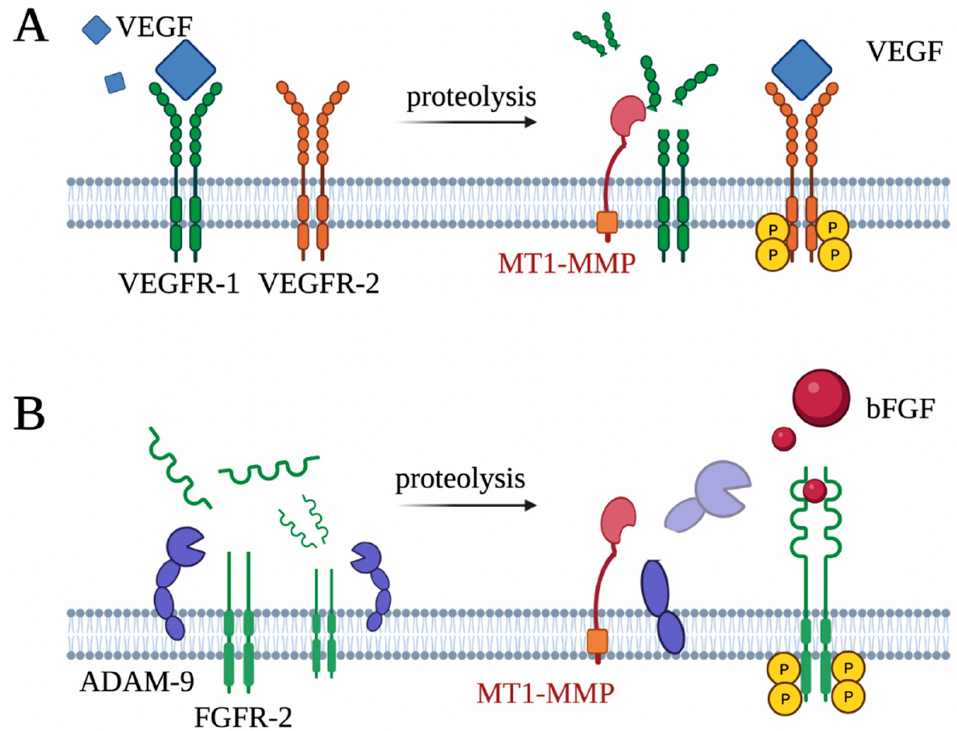
Figure 6. Potential pro-angiogenic role of MT1-MMP through regulation of VEGFR-2 and FGFR-2. ( A ) MT1-MMP is involved in VEGFA/VEGFR-2-mediated angiogenesis. VEGFR-1 exhibits a higher binding affinity with its ligand, VEGFA, than functional VEGFR-2. Membrane anchored MT1-MMP cleaved VEGFR-1, resulting in the enhancement of the interaction between VEGFA and VEGFR-2. ( B ) MT1-MMP regulates bFGF/FGFR-2-mediated angiogenesis. FGFR-2 is proteolyzed by ADAM-9, resulting in the elimination of the FGFR-2-downstream signal. MT1-MMP protects FGFR-2 by shedding an active ADAM-9 and restoring bFGF/FGFR-2-mediated angiogenesis.